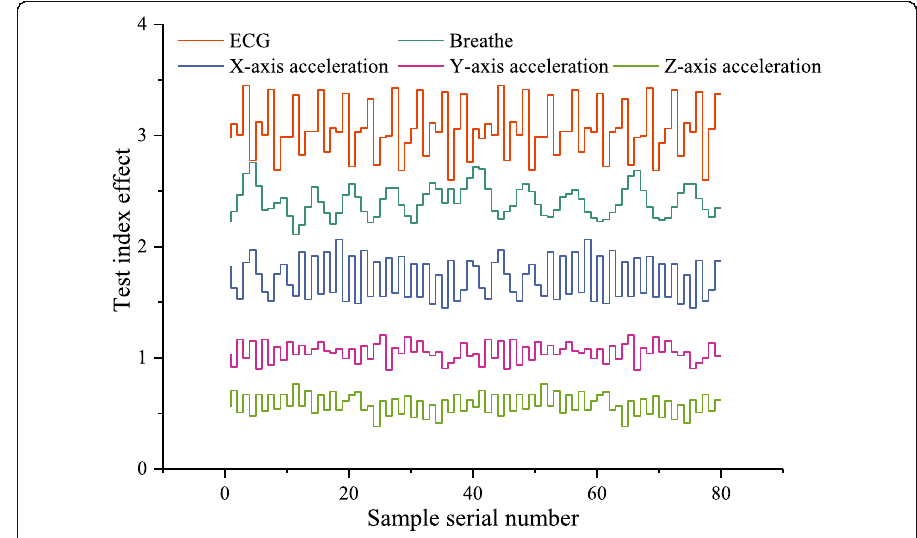
Fig. 6 Test values of cardiopulmonary physiological signals — exercise intensity 6 km/h